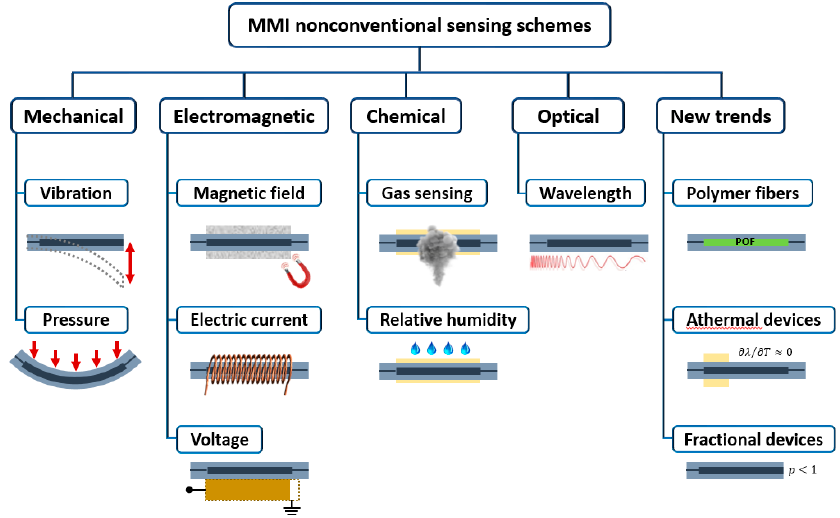
Figure 1. Schematic overview of the structure of the present review.